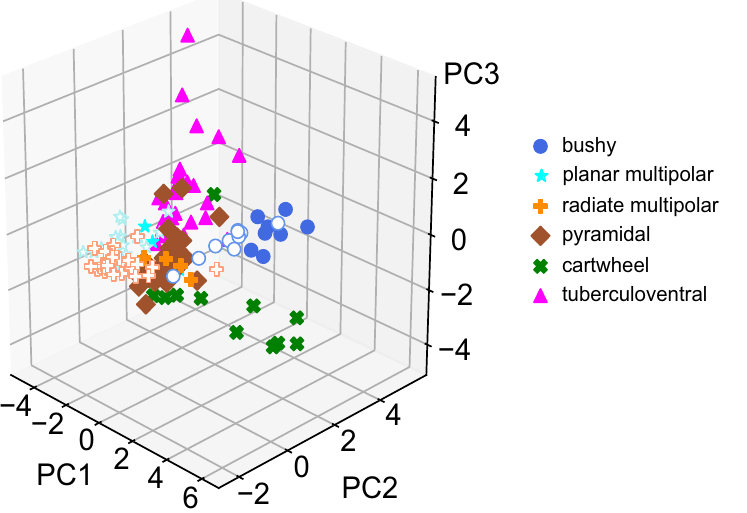
Fig 5. Principal components analysis (PCA) on the same data set as Fig 4. The PCA method is not supervised by cell type, and so the results depend only on factors that maximize the variance. The PCA successfully separated the cell classes, but did not have good accuracy with cross-validation. The view shown is the same format as Fig 4A.